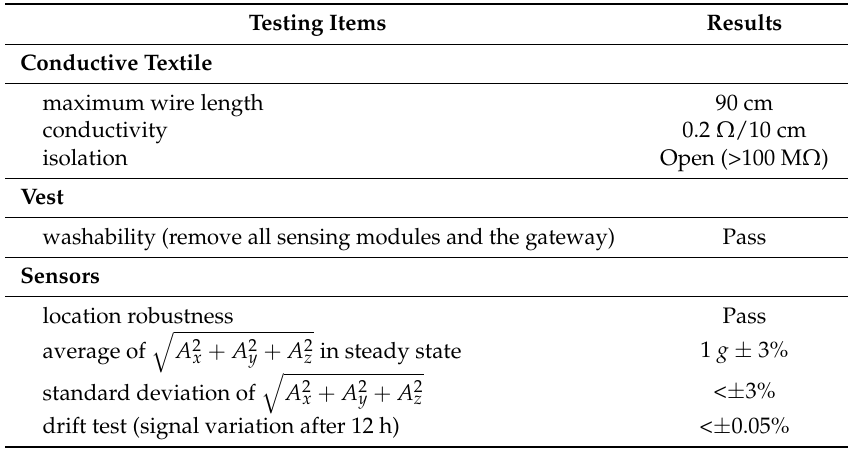
Table 1. Robustness test results: design specification, washability, and signal